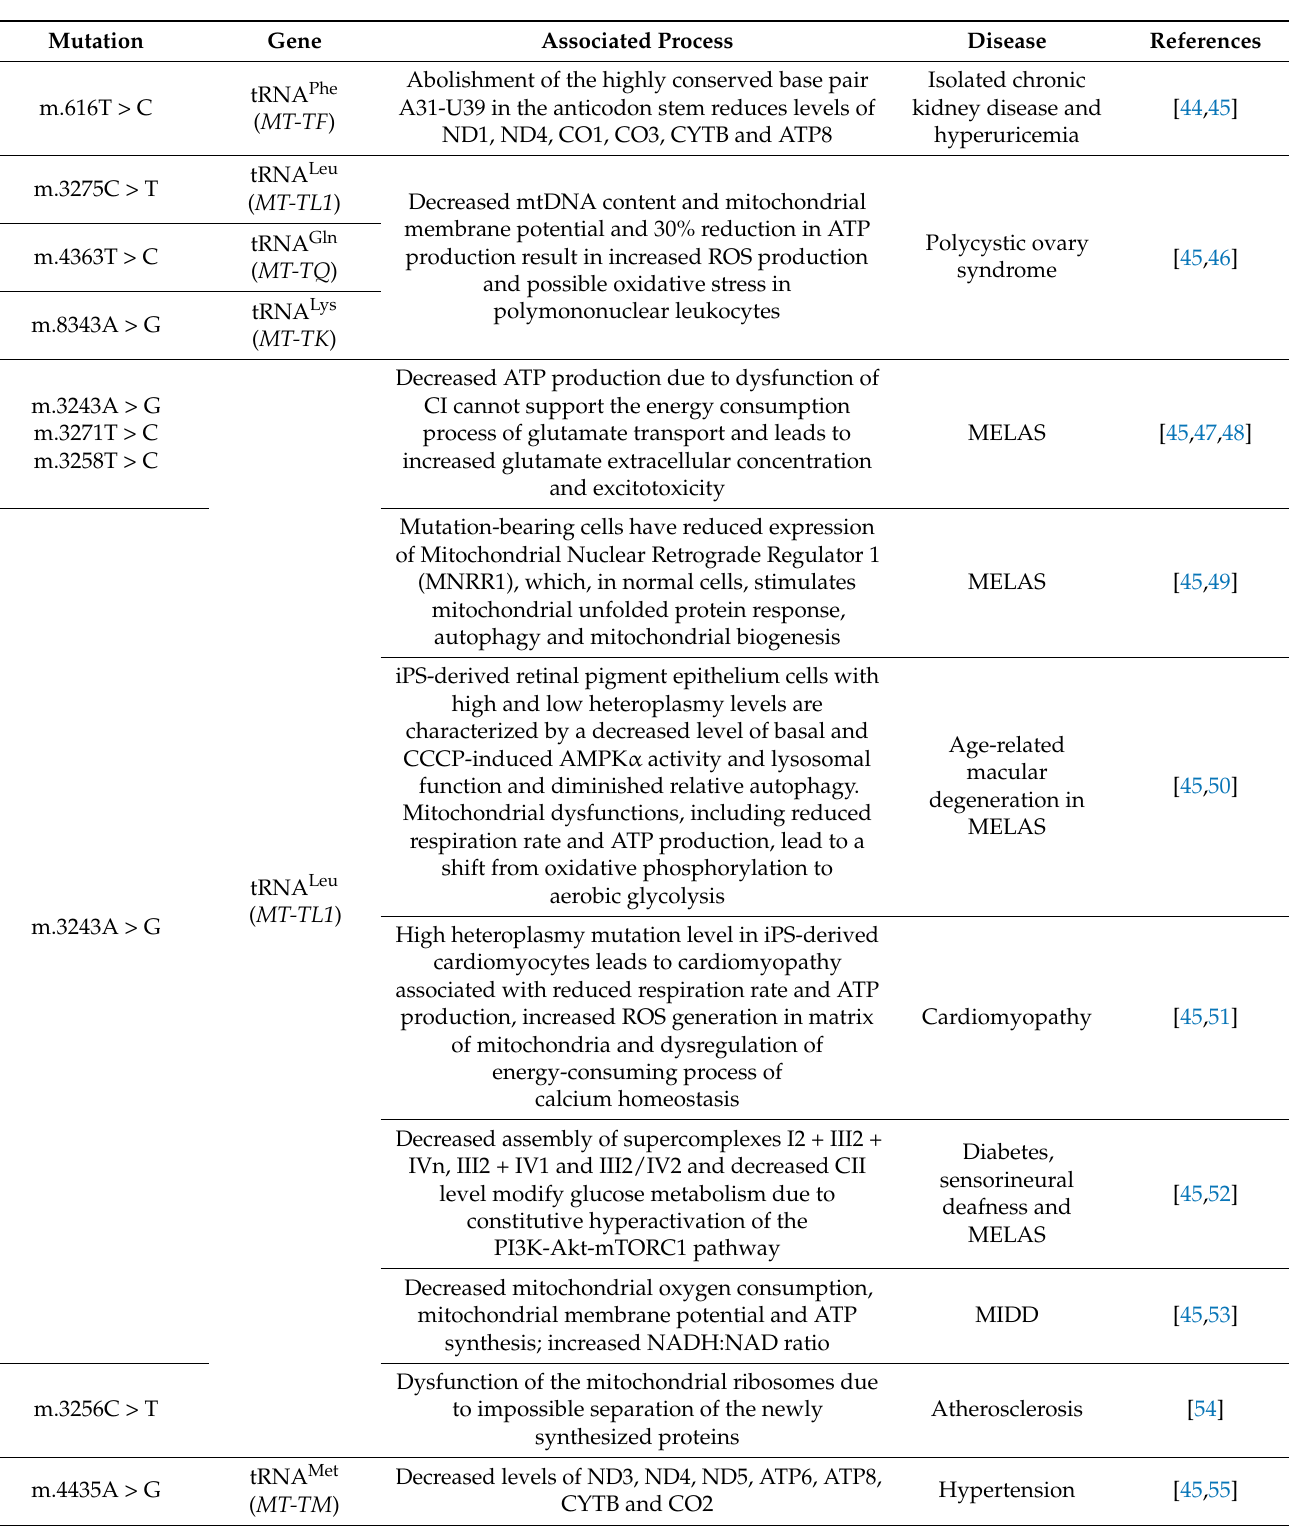
Table 2. mtDNA mutations associated with mitochondrial diseases and other